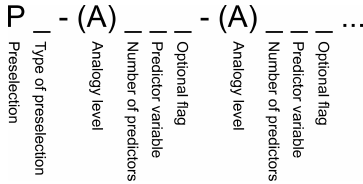
Figure 2. Proposed nomenclature to describe the AM structure.